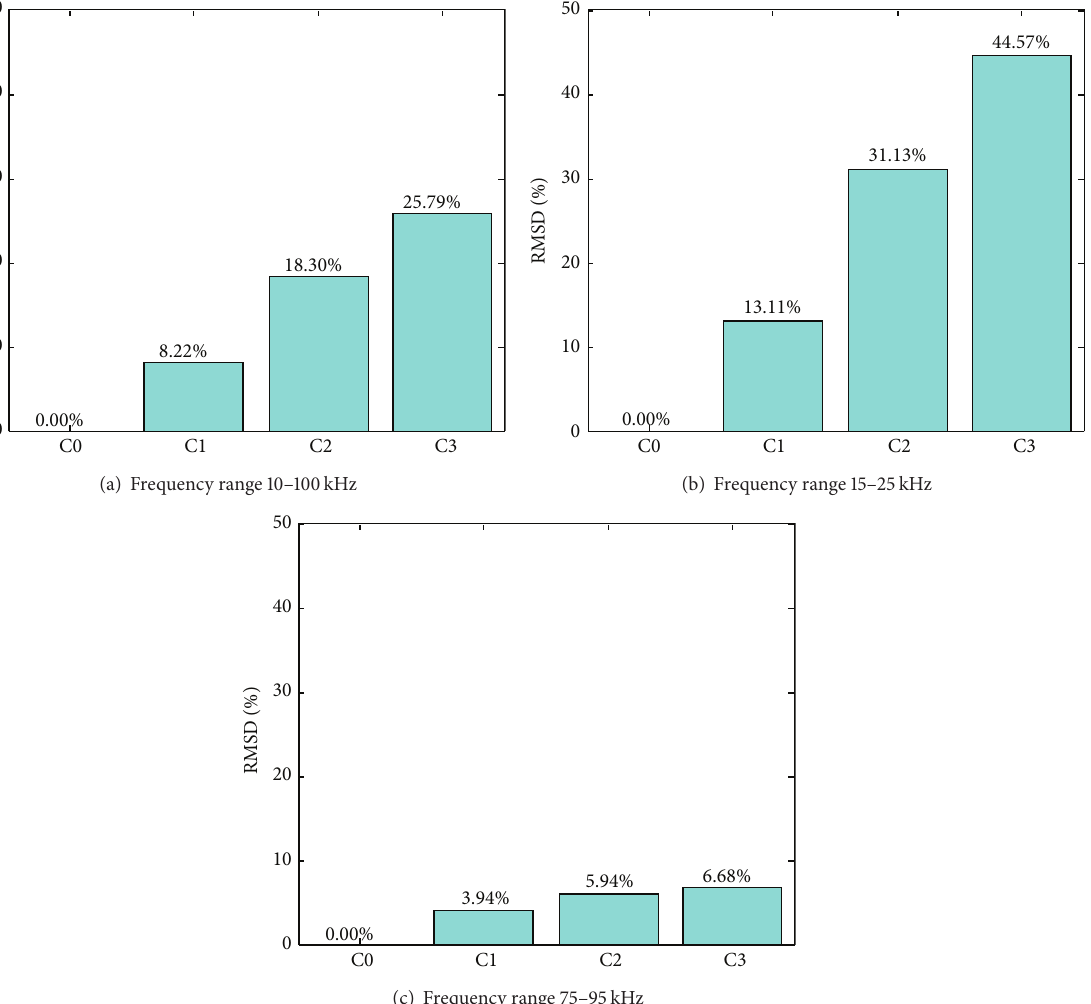
Figure 9: Contact stiffness monitoring by RMSD